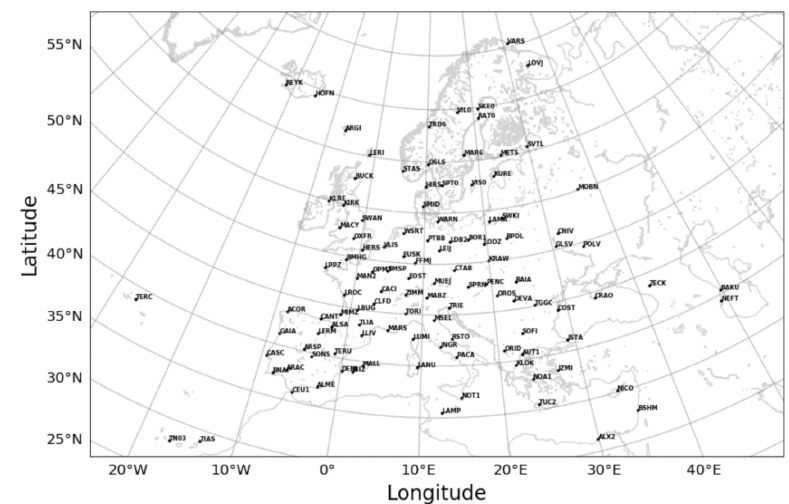
Figure 1. Location of the GPS stations selected for this